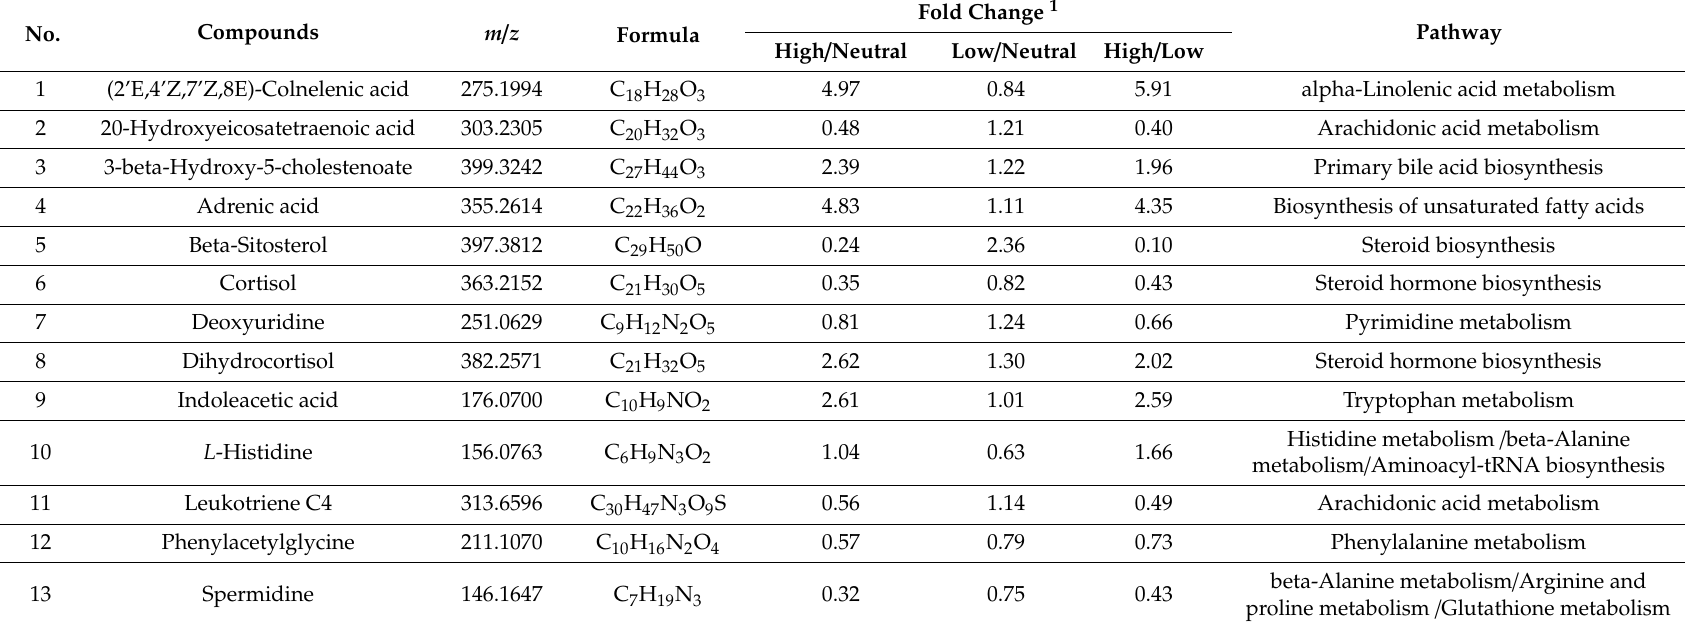
1 Fold change represents ratios of the normalized intensity of the metabolites in plasma of growing pigs at two di ff erent ambient temperatures. The low, ambient temperature at 18 ◦ C; Neutral, ambient temperature at 23 ◦ C; High, ambient temperature at 32 ◦ C. Fold change > 1 represents the metabolite was up-regulated, and fold change < 1 represents the metabolite was